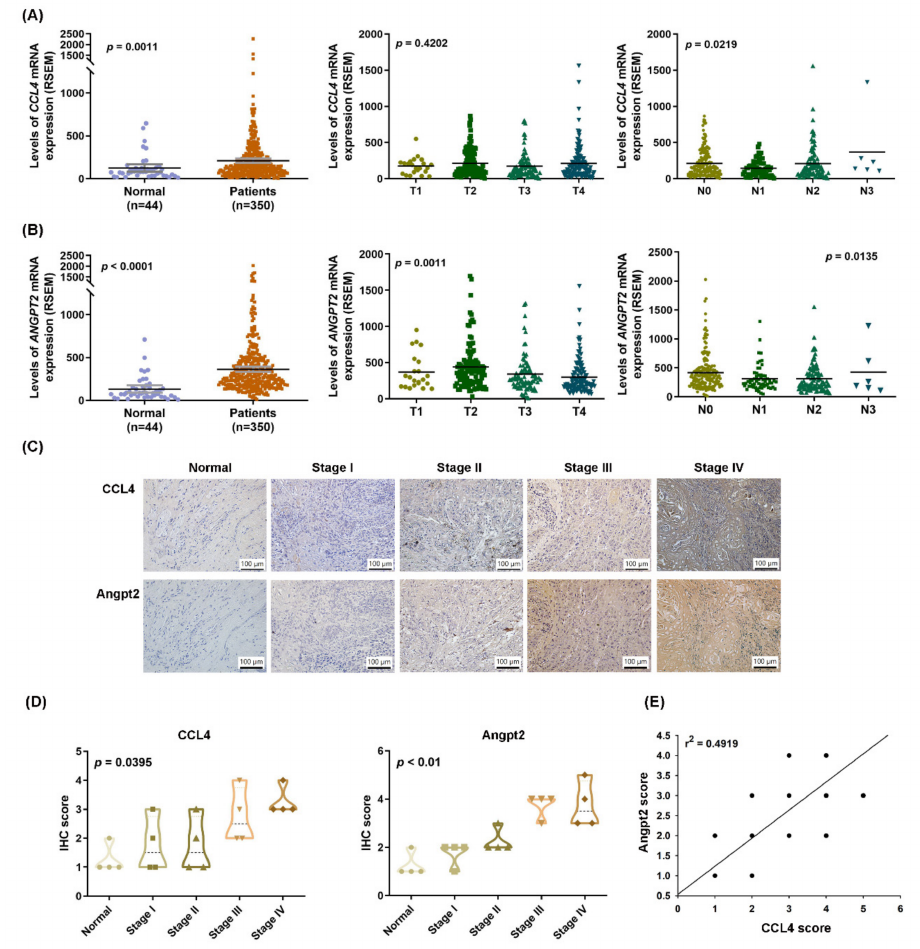
Figure 1. Clinicopathological characteristics of CCL4 and Angpt2 expression in OSCC tissue. ( A , B ) The expression profiles of CCL4 and ANGPT2 in tumor tissue and normal tissue speci- mens were analyzed in records downloaded from the TCGA database. ( C , D ) OSCC and adjacent normal tissue specimens from China Medical University Hospital were subjected to IHC evaluations with CCL4 or Angpt2 antibodies, and the positive staining percentages of the areas were scored as: 1 (<20%), 2 (20–40%), 3 (40–60%), 4 (60–80%), or 5 (80–100%). ( E ) A positive correlation was observed between CCL4 and Angpt2 expression (Spearman’s rank correlation coefficient, r 2 =